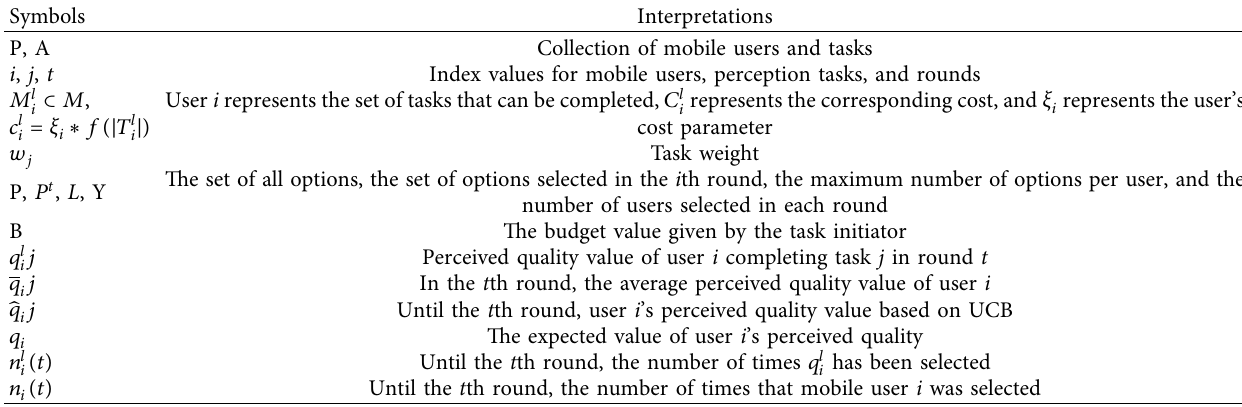
Table 1: The main symbols and